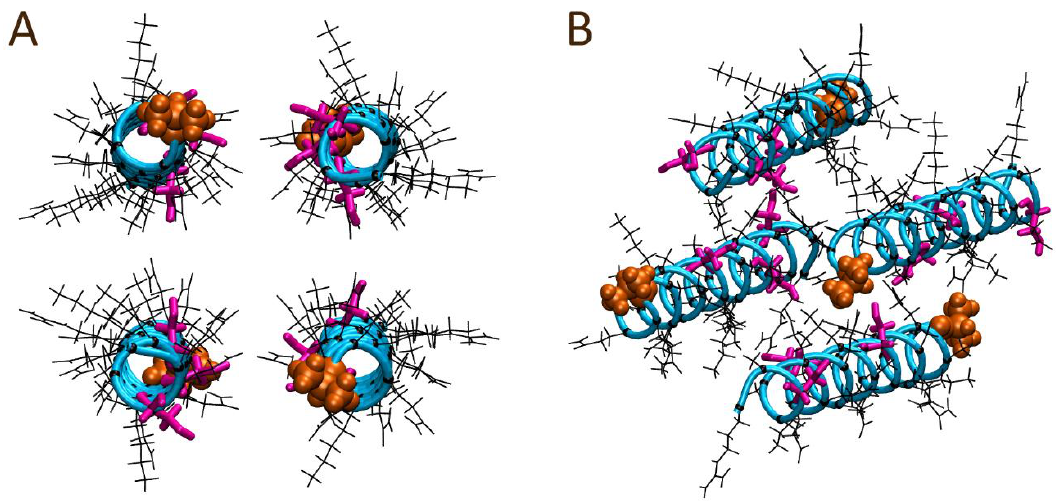
Figure 7. Starting peptide alignment for the solution bound four AR28 peptide system modelled with a head-to-tail alignment: ( A ) front and ( B ) perspective views. The N-terminal alanine is shown in orange; the peptide backbone atoms are depicted as the cyan tube; Ser12, Ser20, and Ser26 sidechains are colored magenta; and all other sidechains and their respective α-carbons are shown in black.